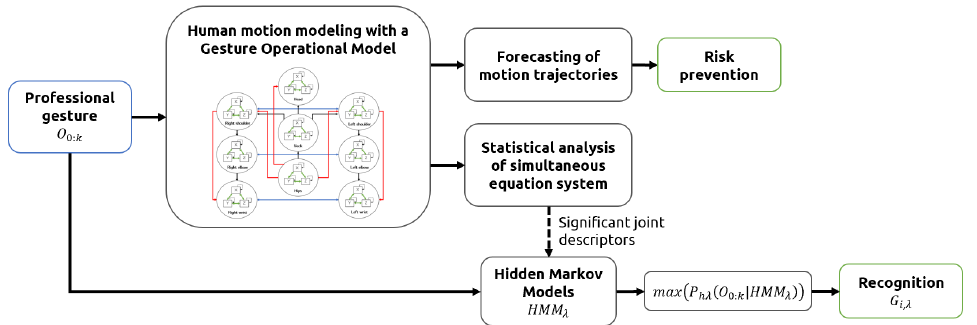
Figure 1. Methodology